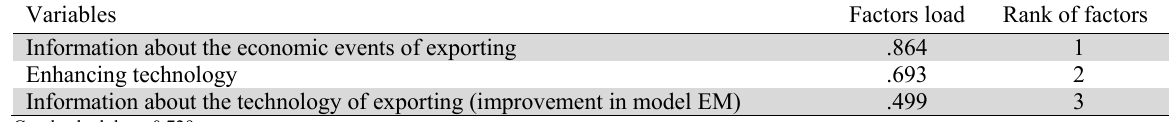
The summary of having update factors influencing on creativity Variables Factors